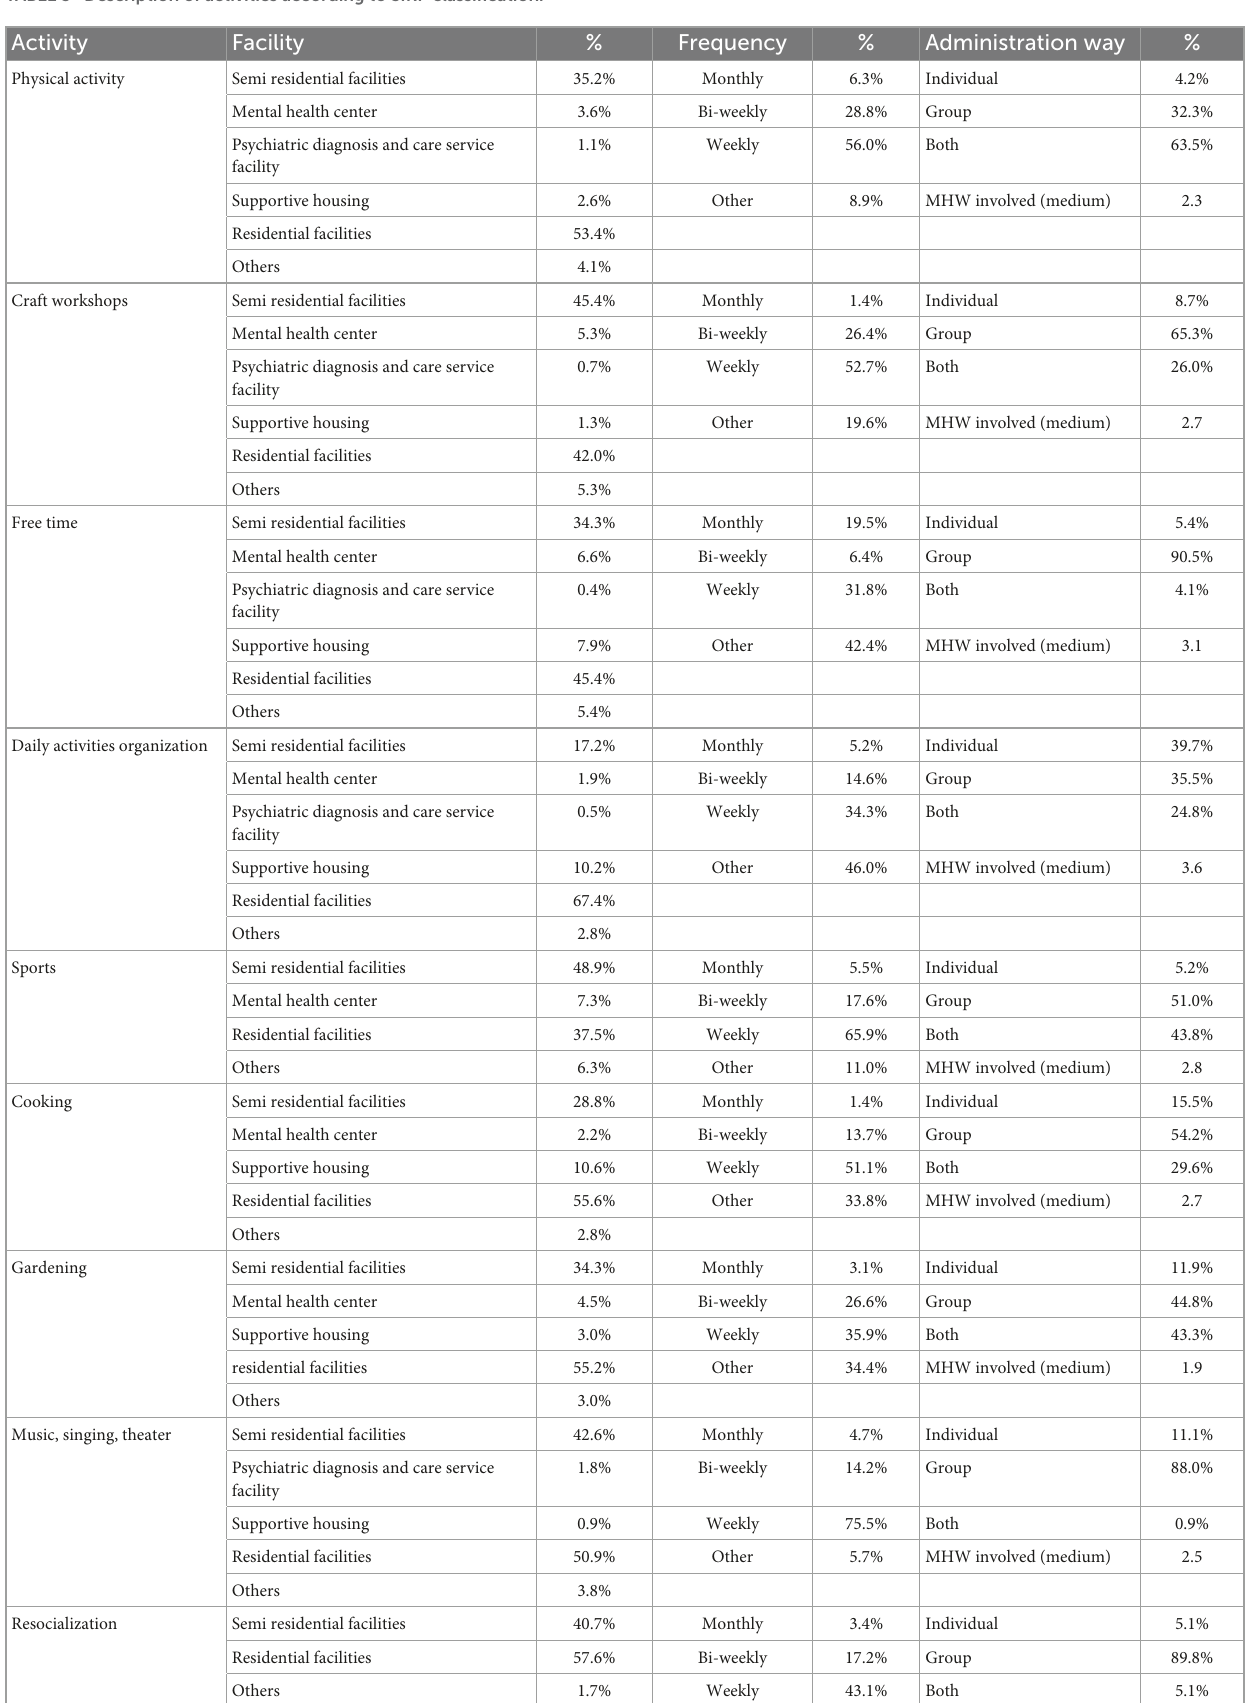
TABLE 3 Description of activities according to SIRP